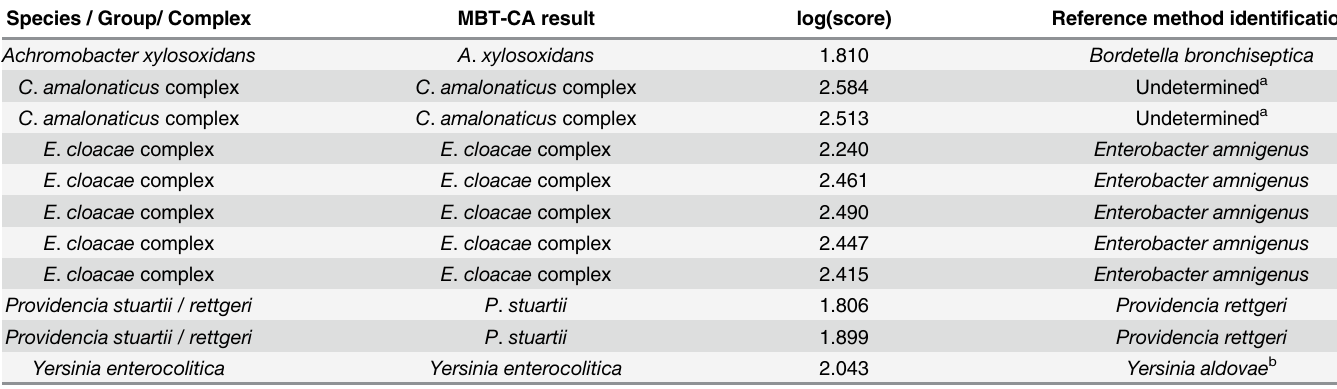
Table 4. Details of incorrect